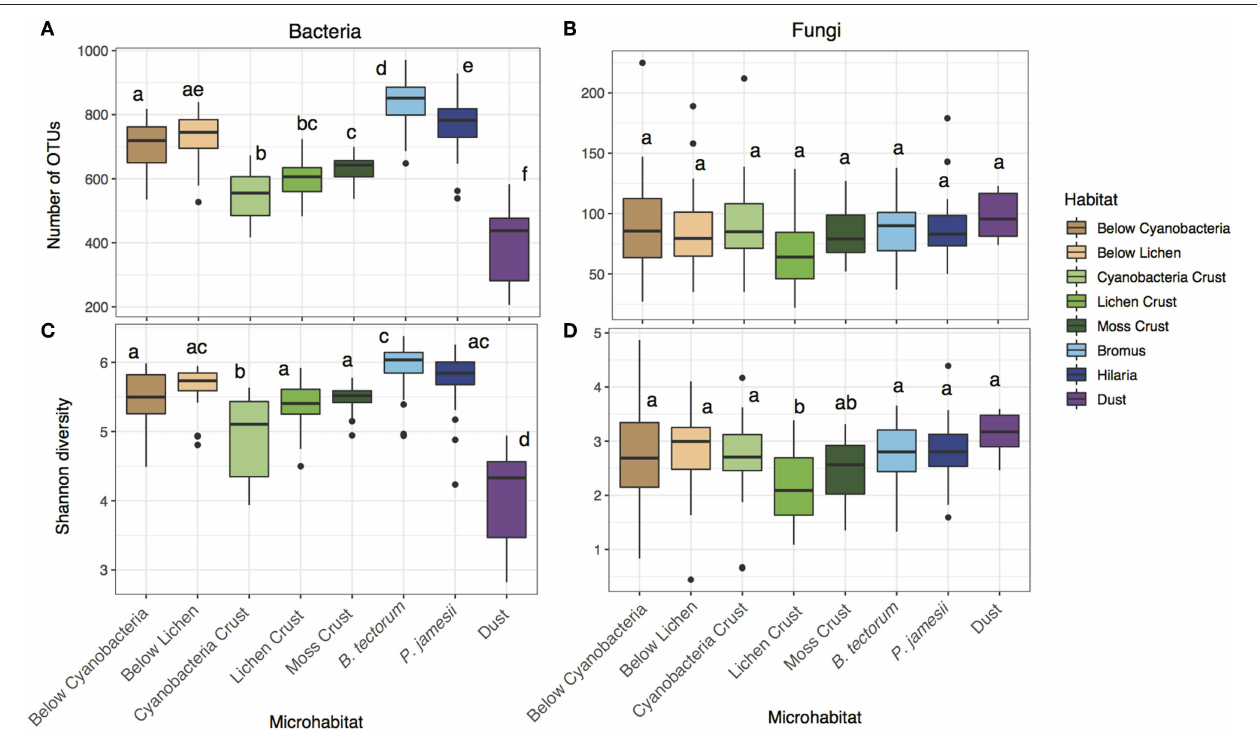
FIGURE 1 | Microhabitat variation in (A) bacterial richness, (B) fungal richness, (C) bacterial diversity, and (D) fungal